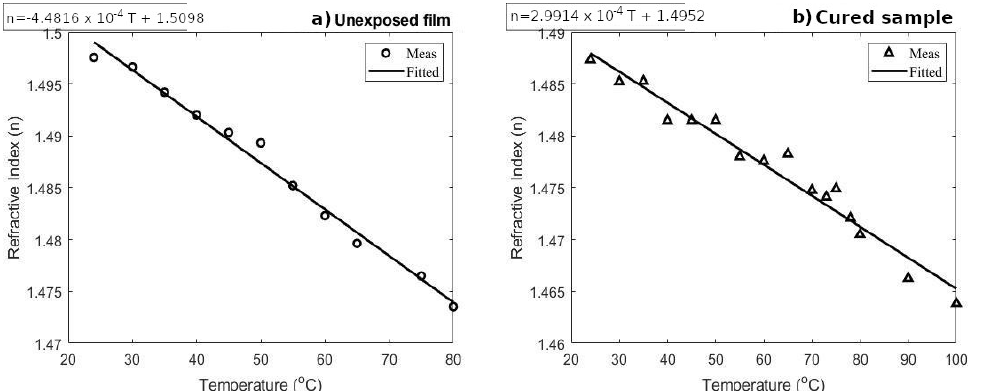
Figure 6. Refractive index variation depending on temperature for the ( a ) unexposed/unrecorded samples and ( b ) cured